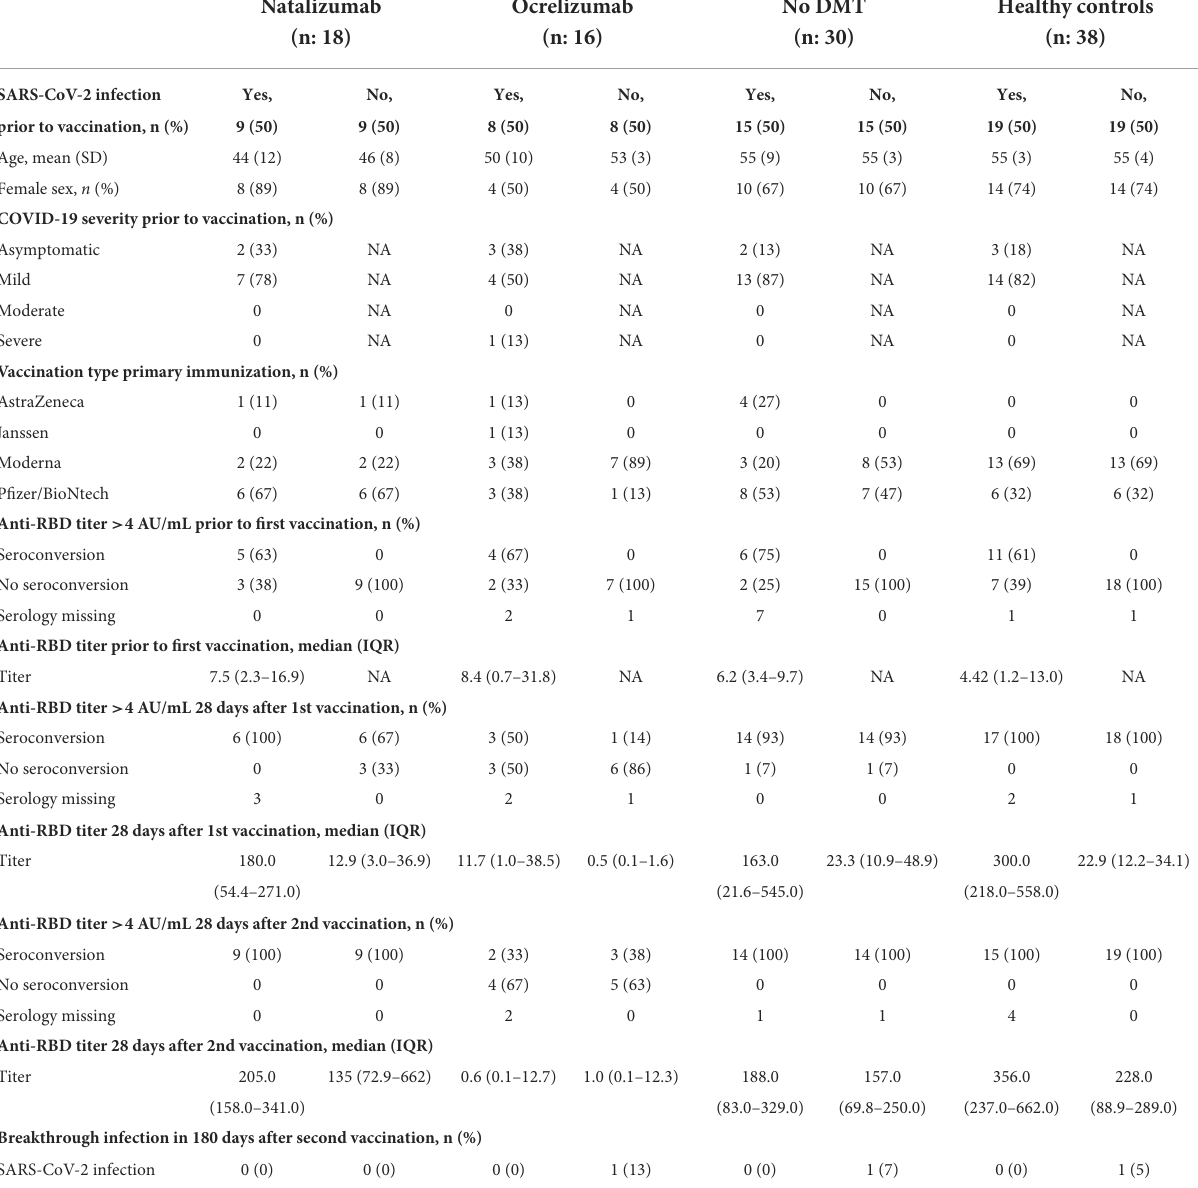
TABLE 1 Baseline characteristics and data on humoral